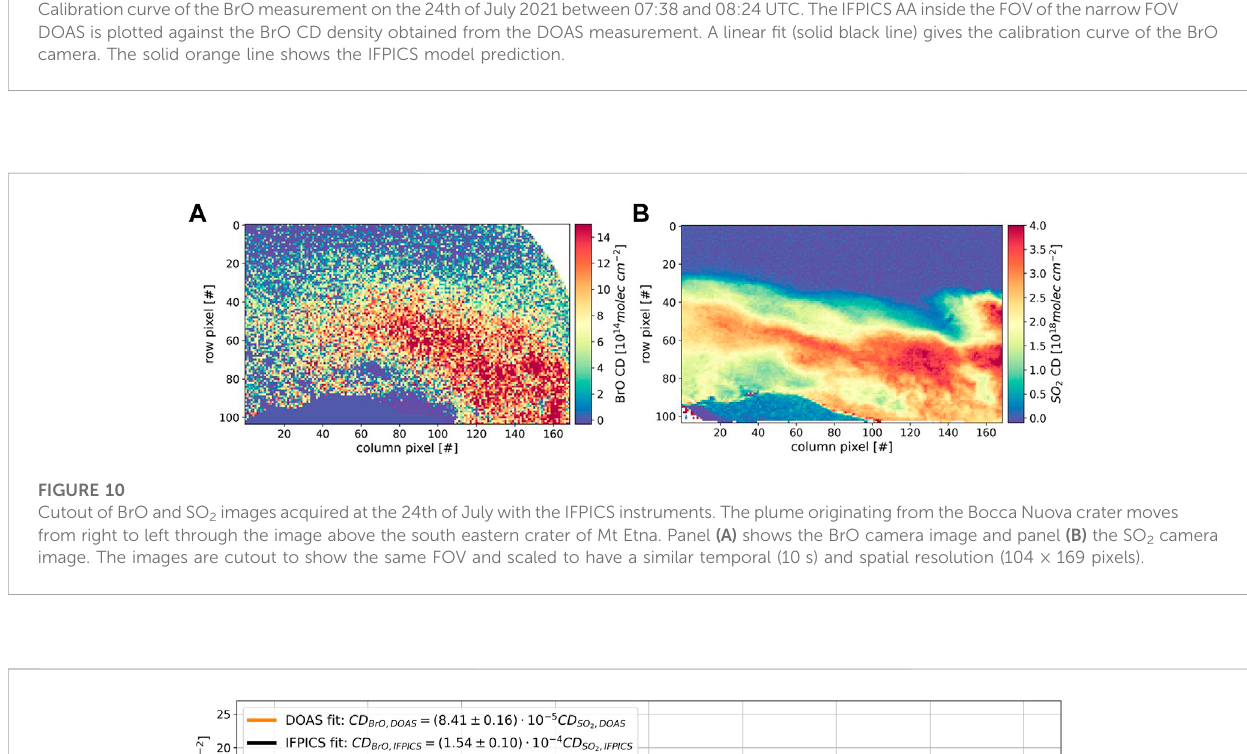
the BrO IFPICS data is subtracted (see Figure 9). The result is shown in Figure 11 (grey dots) and fi tted with a linear function (solid black line) resulting in a BrO/SO 2 ratio of (8.41 ± 0.16) x 10 – 5 with a correlation coef fi cient of R = 0.37. This ratio is compared to the DOAS measurement of the BrO/SO 2 ratio (orange color in